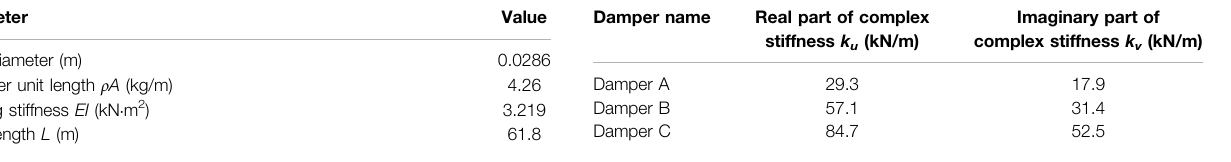
TABLE 4 | Cable parameters. TABLE 5 | Damper parameters estimated by element